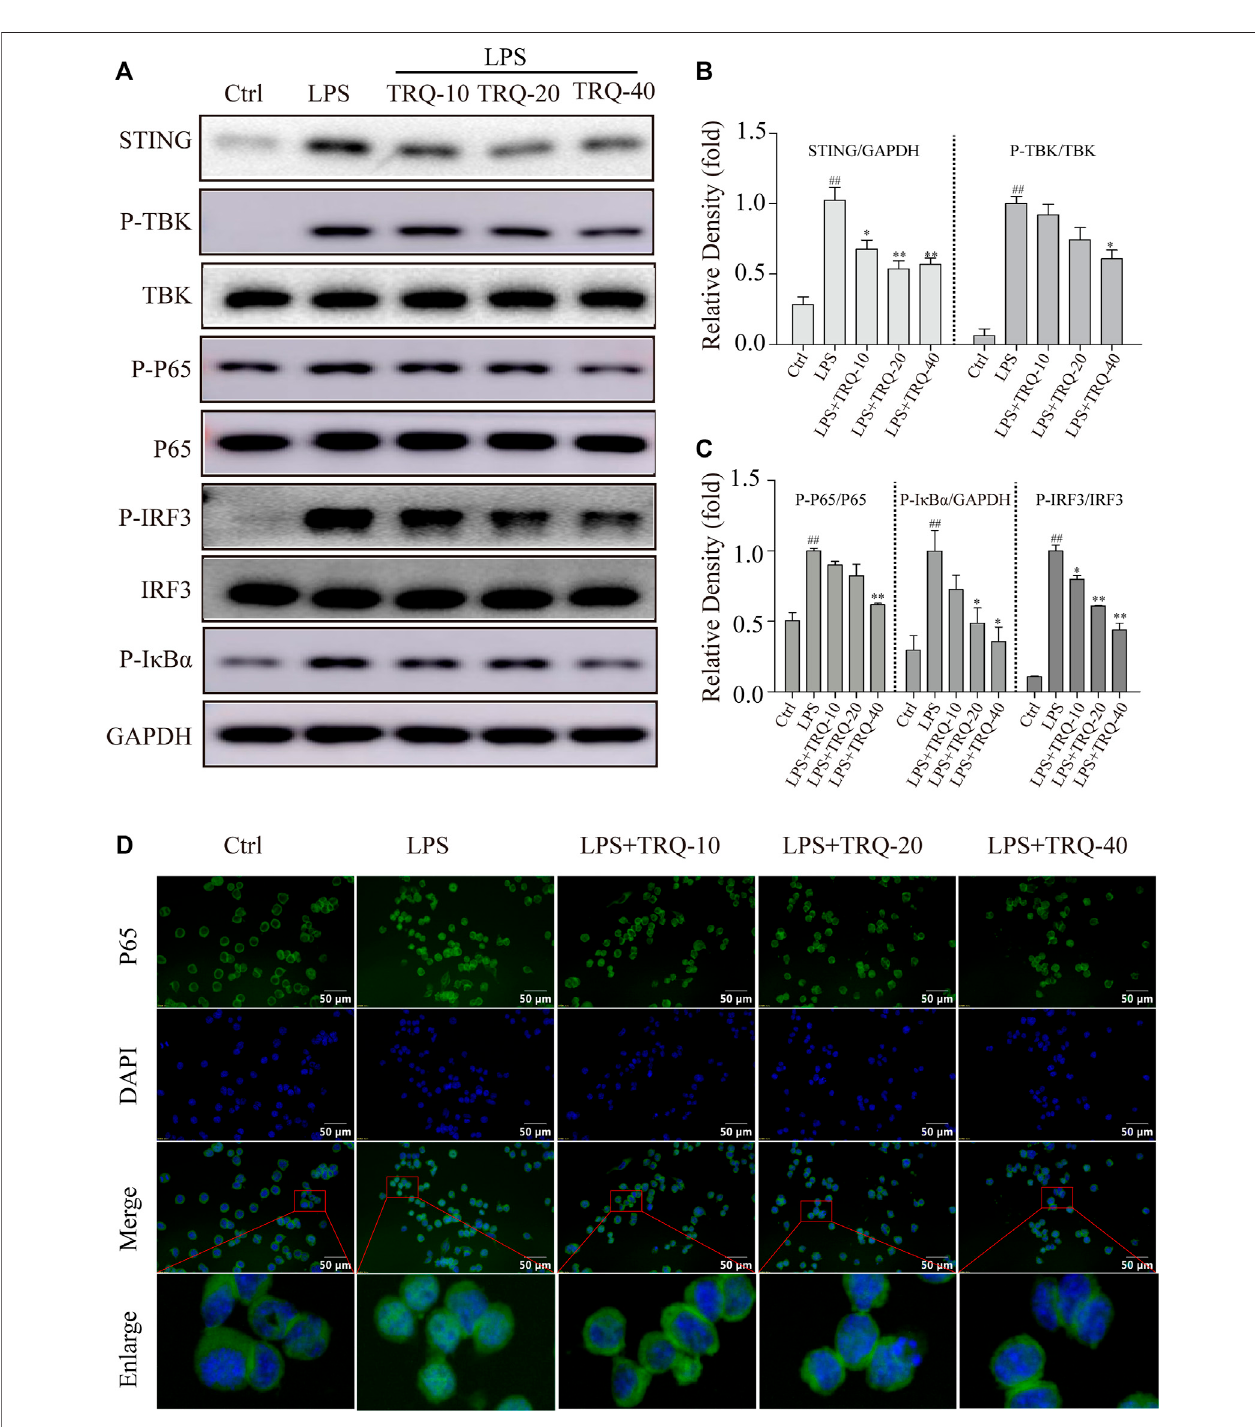
FIGURE 8 | TRQ suppressed STING-mediated IRF3/NF- κ B signaling pathway in LPS-stimulated RAW 264.7 cells. (A – C) The representative Western blotting measurement of STING, P-TBK, TBK, P-P65, P65, P-IRF3, IRF3, and P-I κ B α in LPS-stimulated RAW 264.7 cells. n (cid:2) 3. (D) The representative images of IF staining of P65. n (cid:2) 5. ## p < 0.01 vs. Ctrl group; * p < 0.05 and ** p < 0.01 vs. LPS group, respectively.